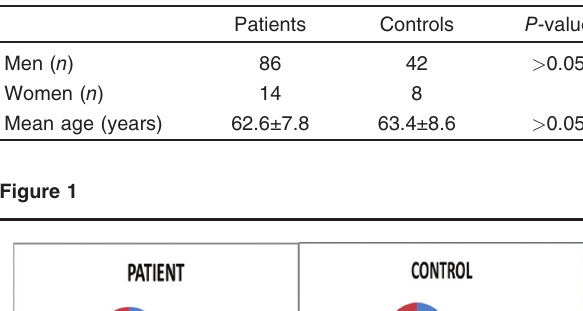
Table 2 Demographic properties of patients and control participants